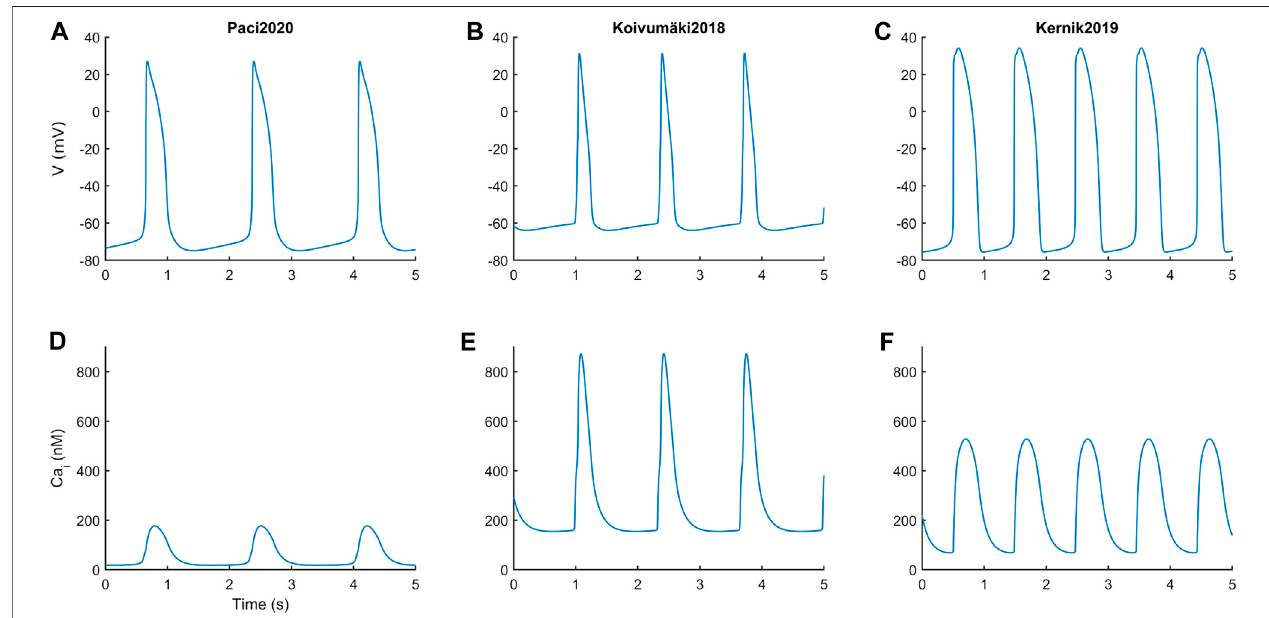
FIGURE 1 | Action potentials (A and B, C) and Ca 2+ transients (D and E, F) in steady state for the three in silico hSC-CM models.